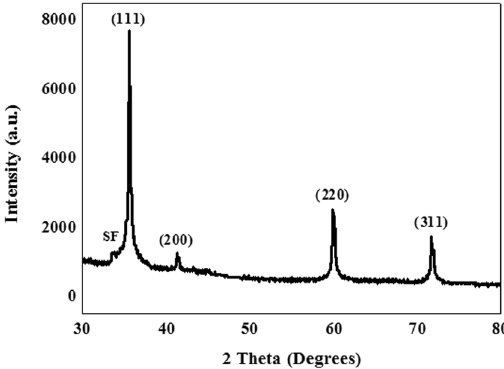
Figure 1. XRD patterns of the white, wool-like, products obtained from the inner wall of the ceramic